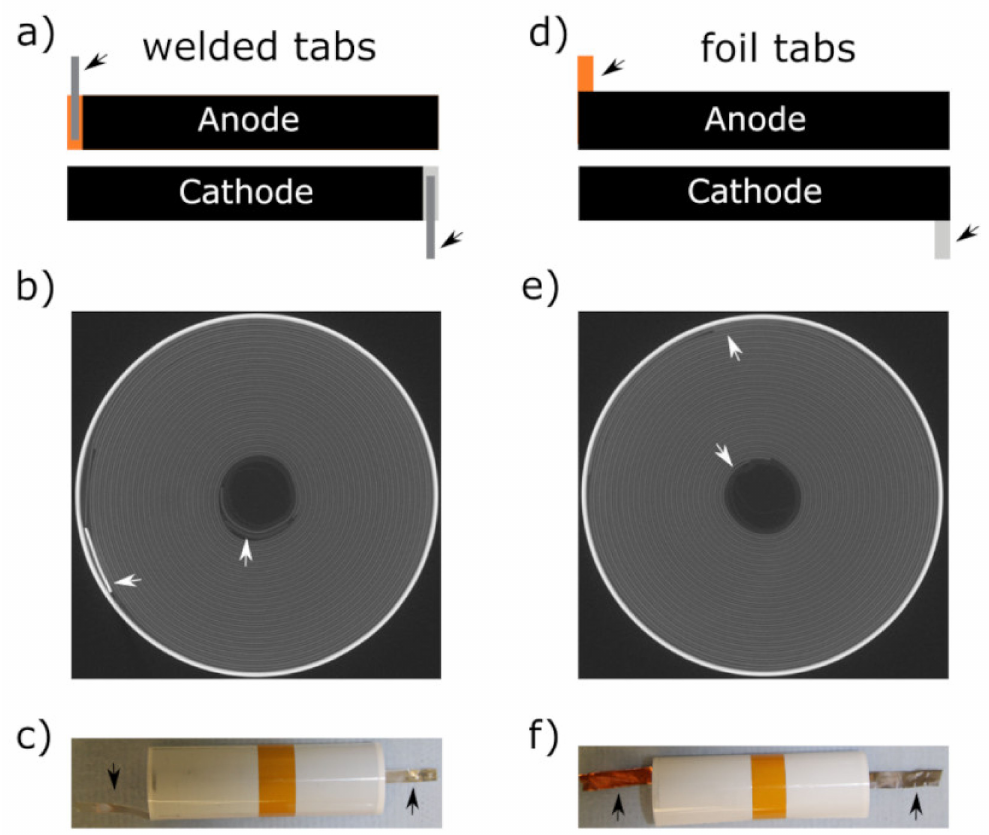
Figure 1. ( a , d ) Unwound anodes and cathodes jellyrolls of 21700 cells with ( a ) welded and ( d ) foil tabs. ( b , e ) X-ray CT images of 21700 cells with ( b ) welded and ( e ) foil tabs. ( c , f ) Photographs of jellyrolls ( c ) welded and ( f ) foil tabs. The arrows mark the positions of the